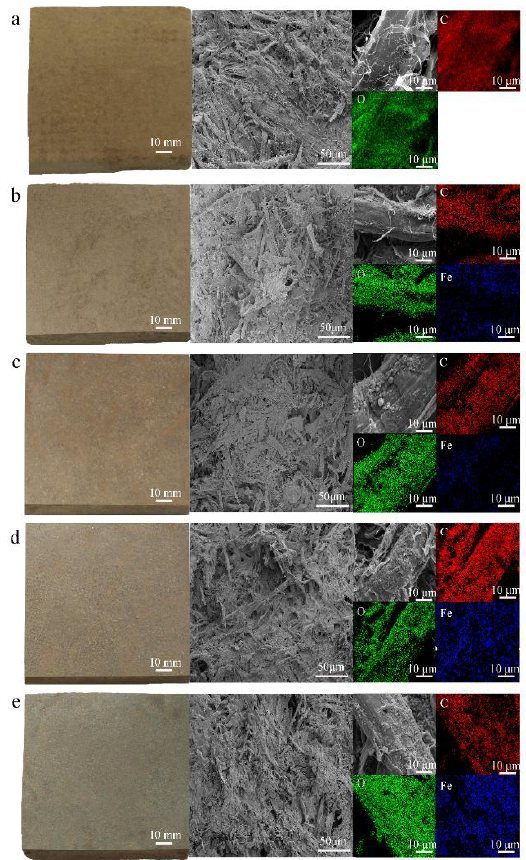
Figure 6. The digital images, SEM and EDX mapping images of pure binderless fiberboard and NFF